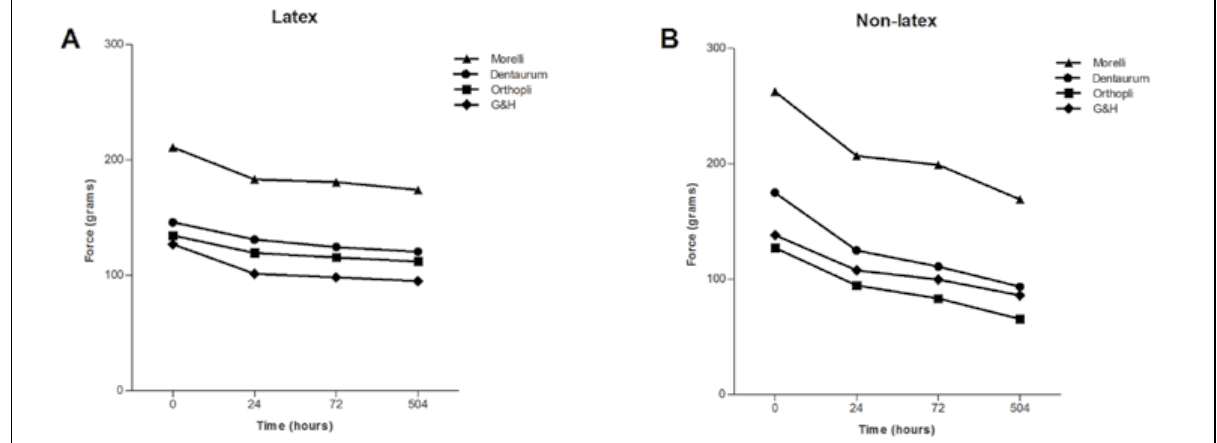
Figure 3. Comparison of the force of the latex (A) and the non-latex (B) elastics: Dentaurum, Orthopli, Morelli and G&H, in all experimental periods. p < 0.05.